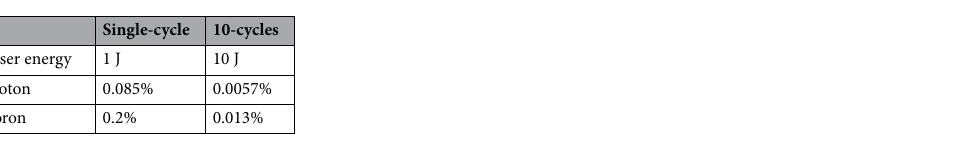
Table 1. Laser energy converted into radial ion kinetic